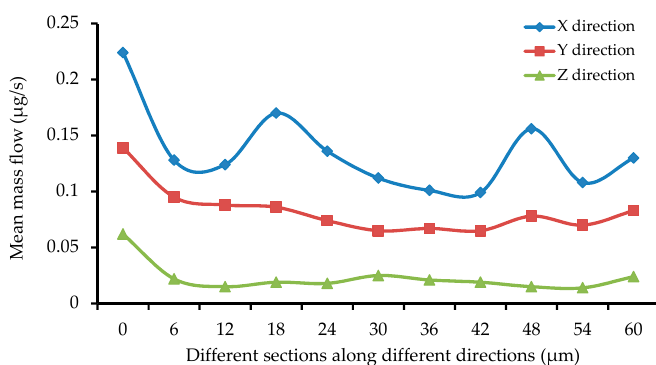
Figure 17. Mean mass flow at different cross-sections.